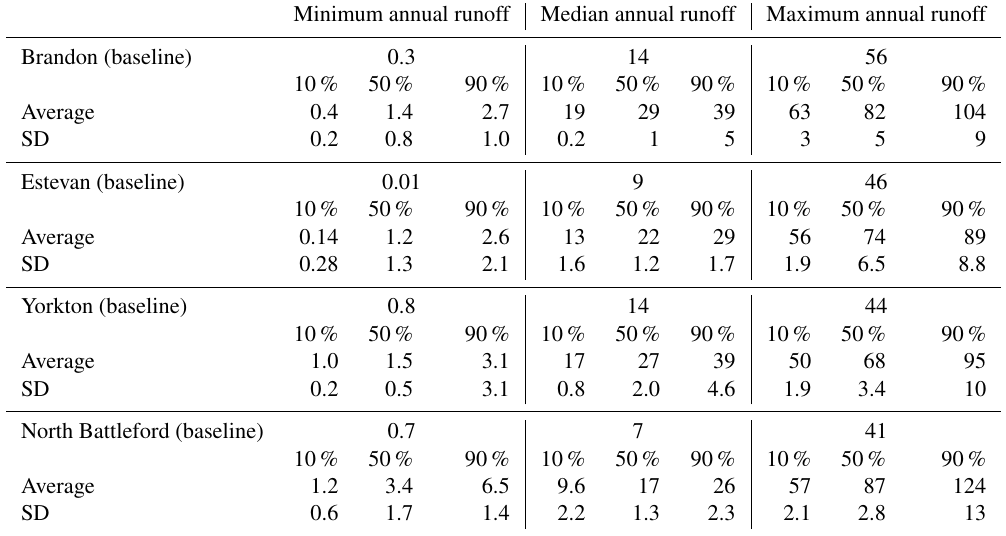
Figure 4. Simulated (CRHM) baseline (recently observed wetland conditions) annual runoff for the PHT virtual basin for three of the four climate locations and observed annual runoff from corresponding WSC hydrometric gauges. The vertical line in the middle of the box denotes the mean, and the top and bottom of the box denote plus or minus 1 standard deviation. The whiskers denote 10th and 90th percentiles. Circles represent values beyond these percentiles. Table 5. Simulated annual runoff (mm) for each drainage scenario for each climate forcing for the period of simulation. The baseline average for each climate station is provided, as is the average and standard deviation for each set of drainage scenarios at each of the four climate stations. Note: SD is for standard